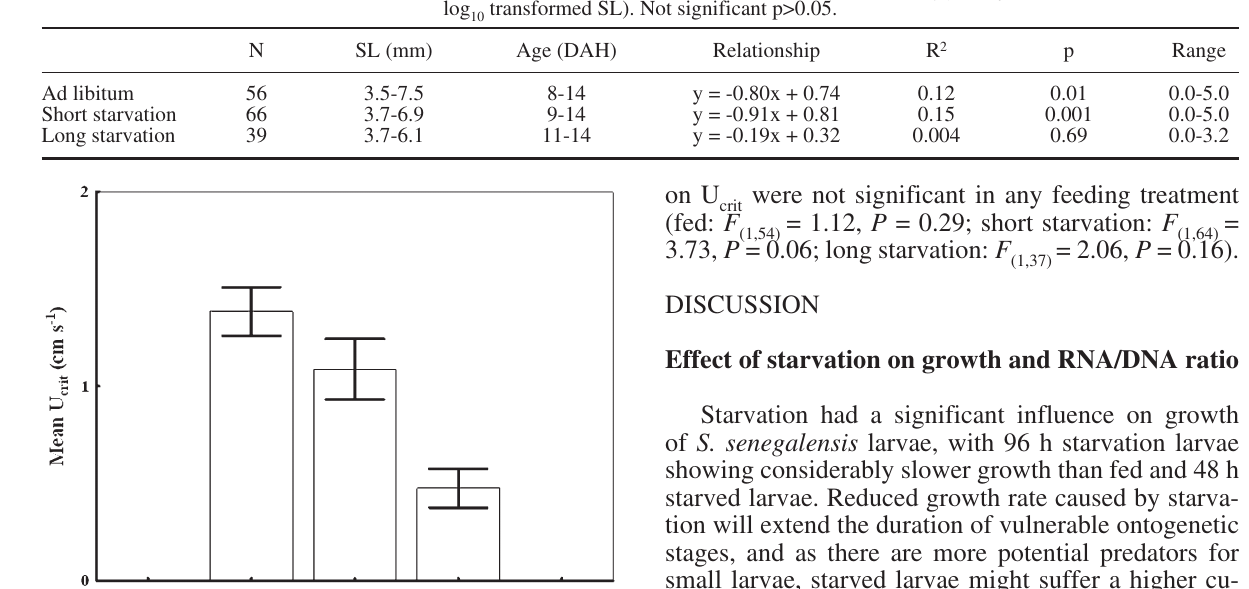
: log transformed) and size (SL: crit 10